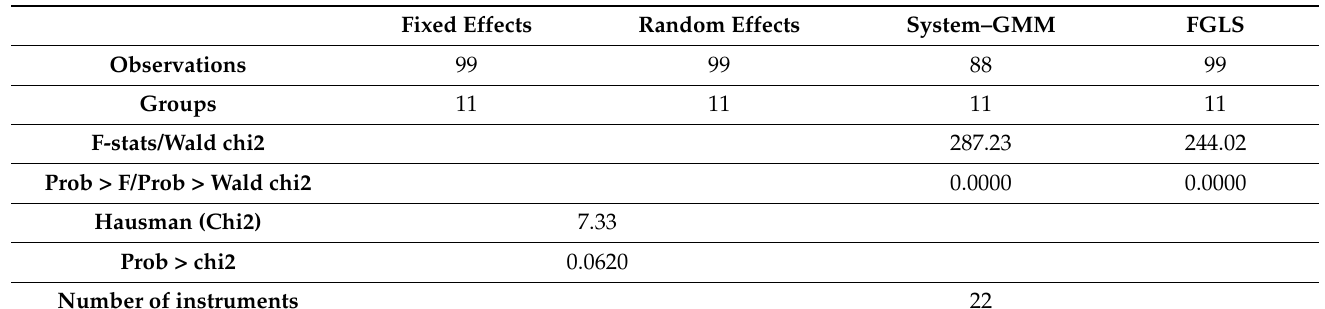
Table A3. Diagnostic tests of the data estimations on the impact of ICT adoption on stock market turnover ratios.